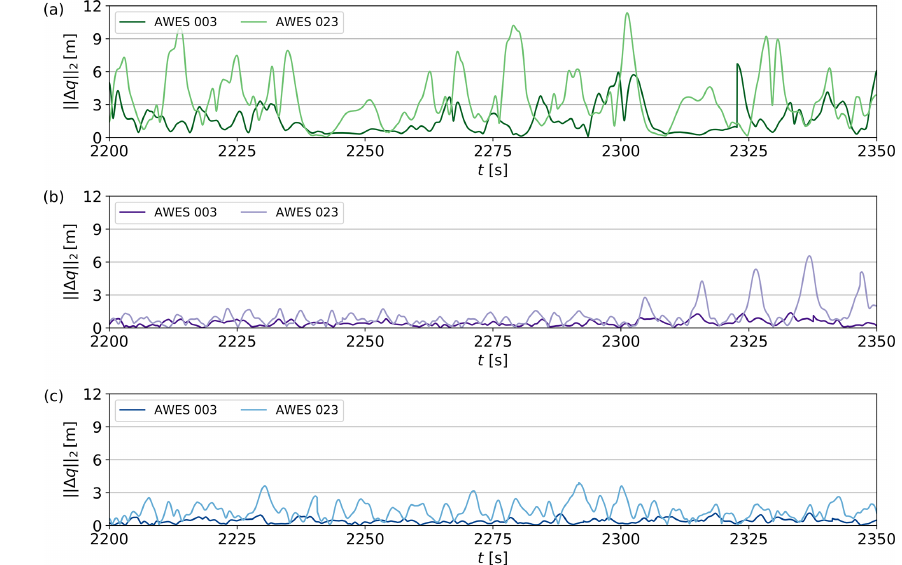
Figure 17. Time series of position offset || q − q r || 2 monitored by the front and rear AWE systems of the central park column ( x = 2000m) for the AWE parks L1 (a) , D1 (b) , and D2 (c)